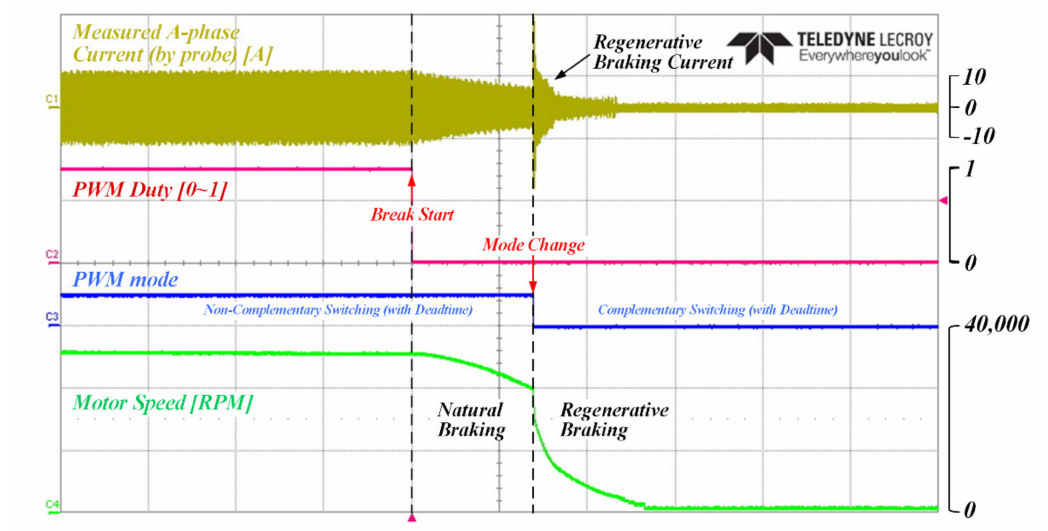
Figure 9. Experimental results of the deceleration operation using the proposed control algorithm (from expanded speed to limited speed and